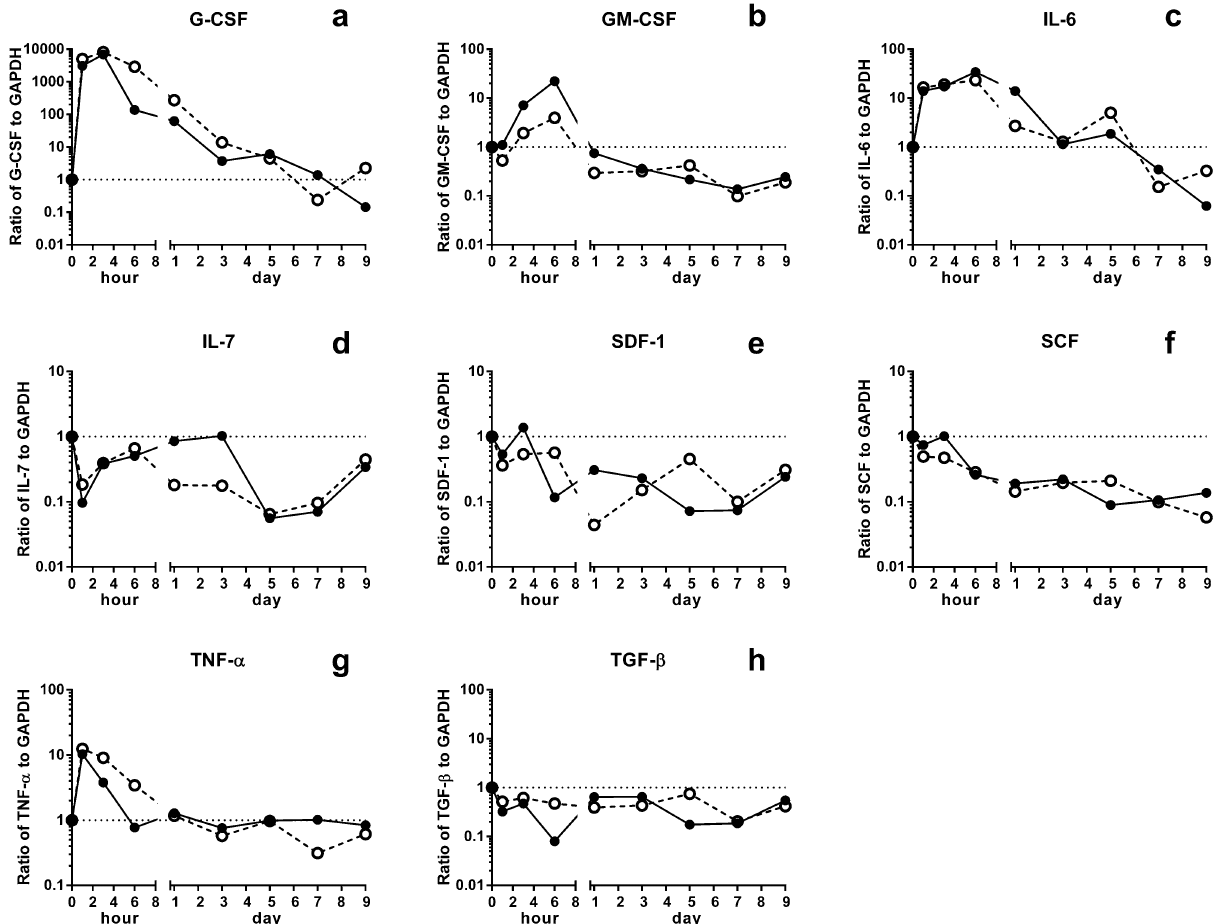
Figure 4. Changes in levels of transcripts encoding regulatory cytokines in the BM after LPS treatment. Changes in the relative levels of transcripts encoding G-CSF, GM-CSF, IL-6, IL-7, SDF-1, SCF, TNF-α, and TGF-β in the BM of young and aged SAMP1/TA-1 mice after LPS treatment are shown. The levels of transcripts encoding positive regulators of myelopoiesis G-CSF ( a ), GM-CSF ( b ), and IL-6 ( c ); encoding positive regulators of B lymphopoiesis IL-7 ( d ), SDF-1 ( e ), and SCF ( f ); and encoding negative regulators of B lymphopoiesis TNF-α ( g ) and TGF-β ( h ) were evaluated in young (closed circles) and aged (open circles) SAMP1/TA-1 mice at 1, 3, and 6 h and at 1, 3, 5, 7, and 9 days after treatment with 25 μg LPS are shown. Values shown for young and aged SAMP1/TA-1 mice after LPS treatment are normalized to the levels in non-treated control young and aged SAMP1/TA-1 mice, respectively. Each bar represents the mean ± S.D. The values in non-treated young and aged SAMP1/TA-1 mice were arbitrarily set to a value of